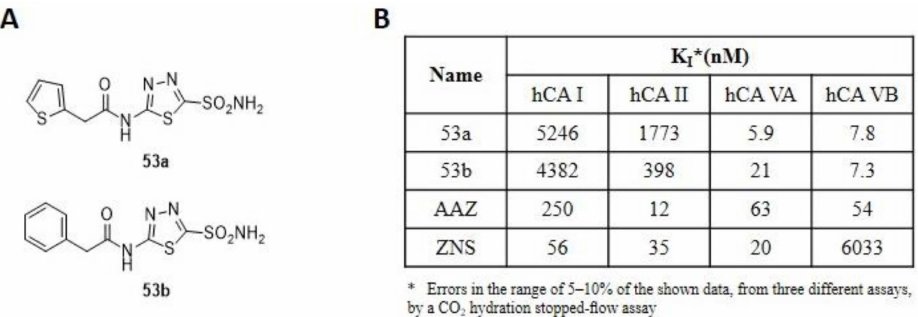
Figure 9. ( A ) Structure of thiadiazole derivatives incorporating R - and S -canphorsulfonyl moieties 53a-b . ( B ) Inhibition data of human CA isozymes I, II (cytosolic), VA and VB (mitochondrial) with compounds 53a ( R ), 53b ( S ) and standard inhibitors ( AZA and ZNS